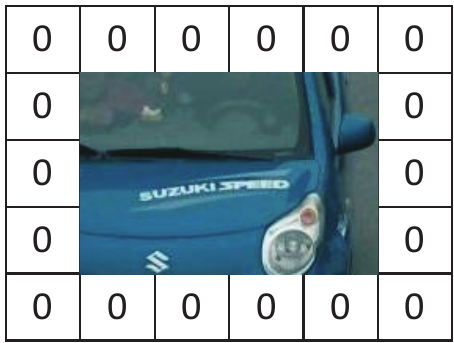
Figure 4. Overview of padding added to the original local